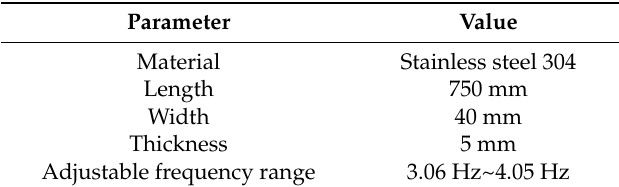
Table 1. Parameters of the primary cantilever beam.